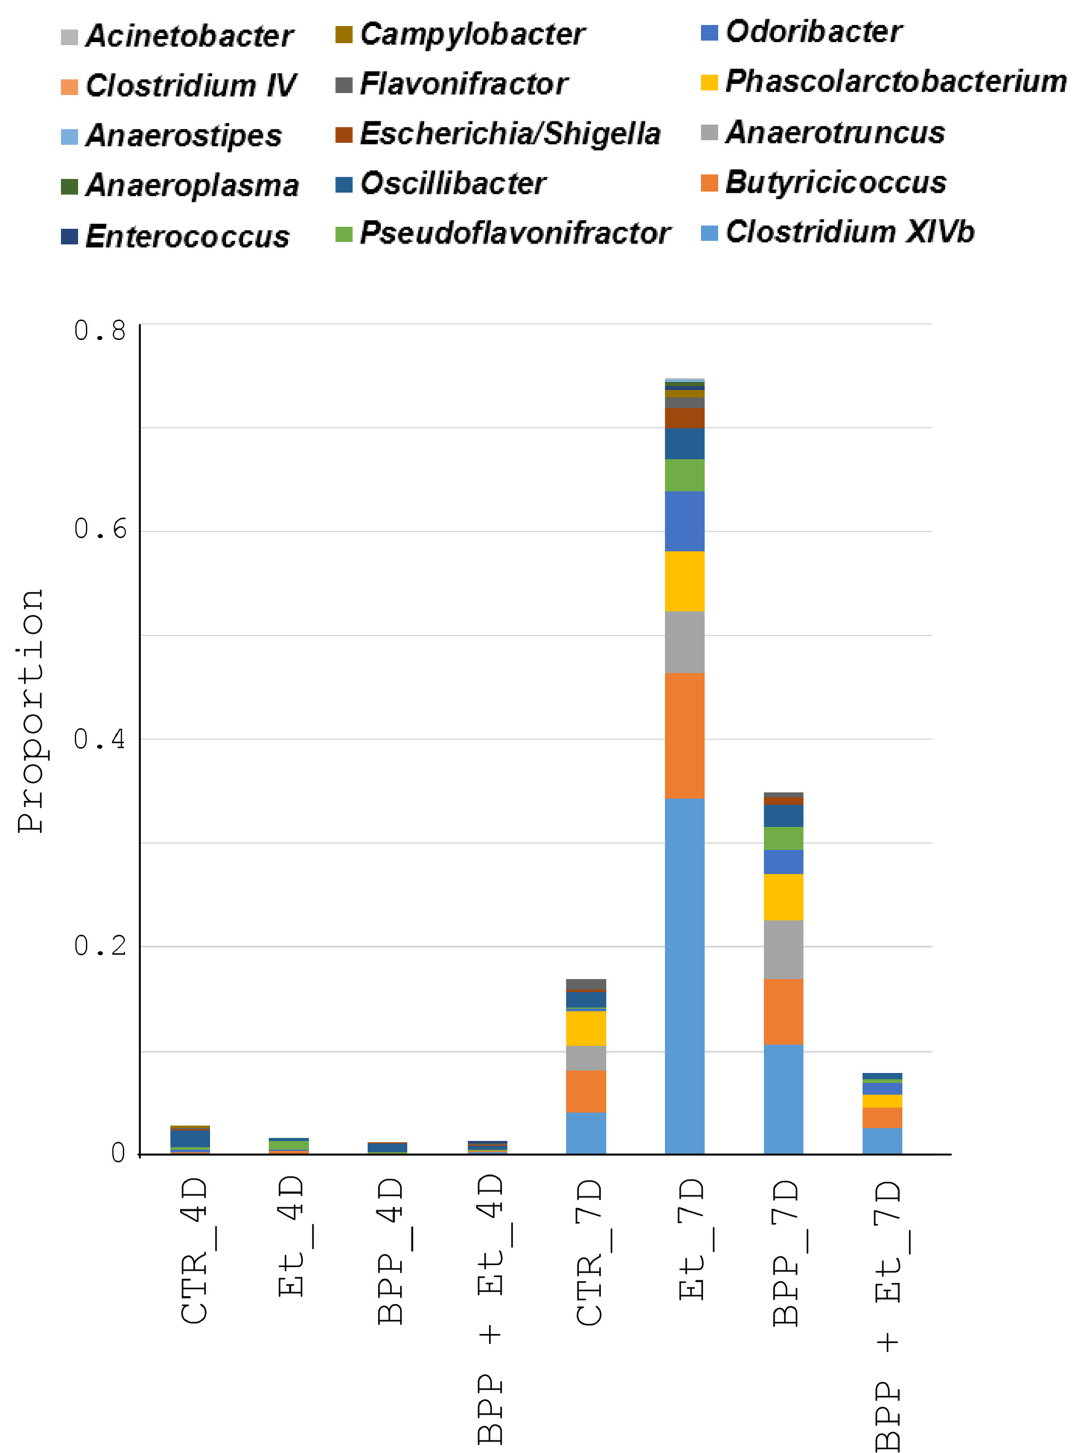
Fig 7. Change in the proportion of the zoonotic bacterial genera in the guts of chickens, fed with or without B . pilosa , following E . tenella infection. The bacterial genera, which decreased in proportion in the guts of the E . tenella -infected chickens by B . pilosa ( Fig 2), were re-plotted into histograms.